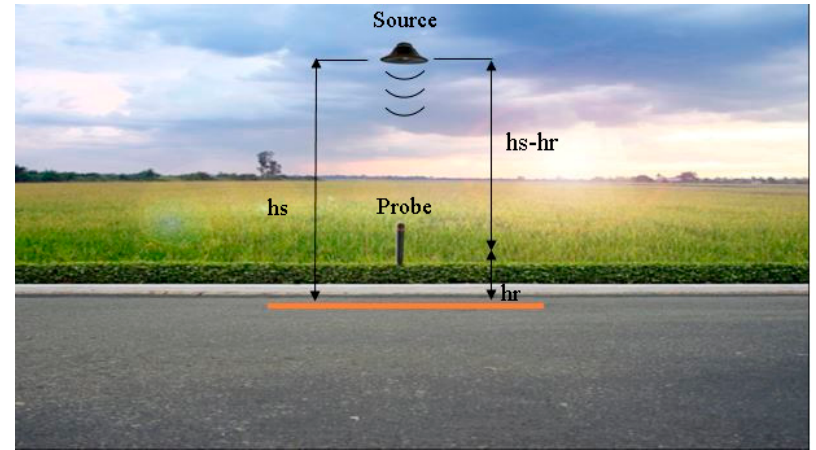
Figure 1. Set-up of the measurement system.